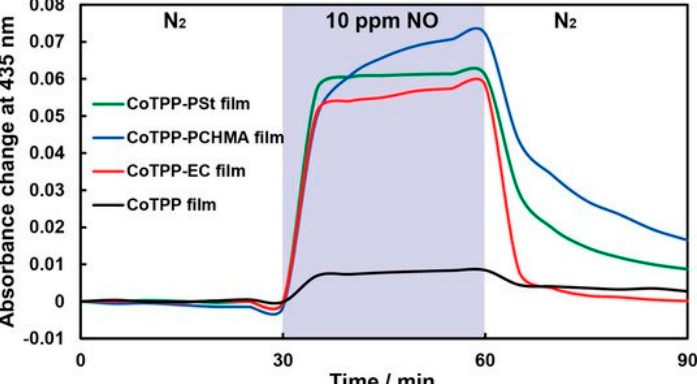
Figure 20. Typical responses of CoTPP film (black), CoTPP-EC film (red), CoTPP-PCHMA film ◦ C. The blue zone indicates the period of NO (green) and CoTPP-PSt film to 10 ppm of NO/N 2 at 100 °C. The blue zone indicates the period of (green) and CoTPP-PSt film to 10 ppm of NO/N 2 at 100